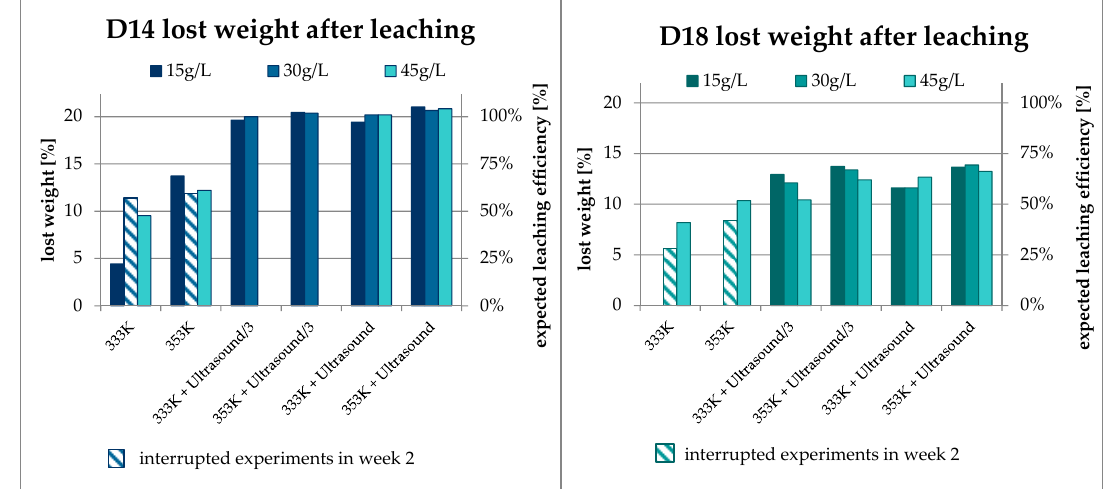
Figure 10. Lost weight for different PCD samples after leaching with different parameters described in the plot. 35 kHz ultrasound varied from “none”, “ultrasound on” for a third of the run time, to “full-time ultrasound”, as shown from left to right.